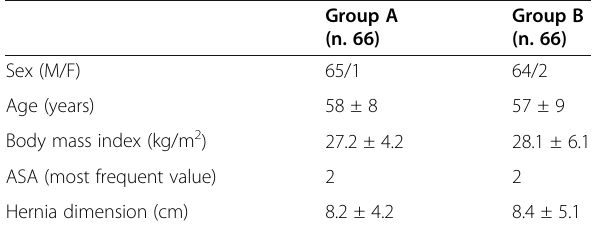
Table 1 Patients ’ characteristics